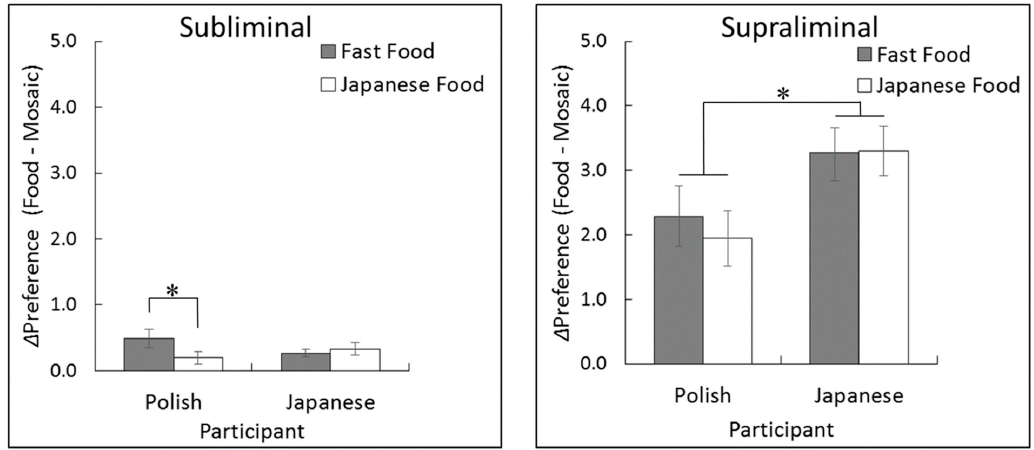
Figure 2. Mean ( ± standard error) preference di ff erence scores (food versus mosaic) for the subliminal Figure 2. Mean (± standard error) preference difference scores (food versus mosaic) for the subliminal (left) and supraliminal (right) rating tasks. *, p < 0.05. ( left ) and supraliminal ( right ) rating tasks. *, p <